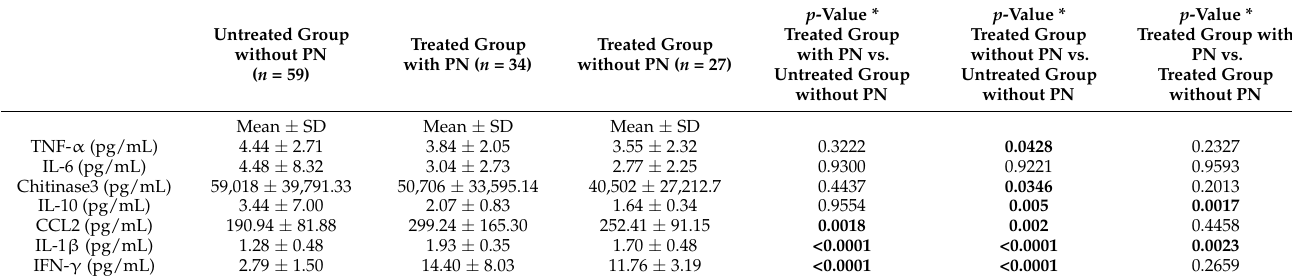
Table 3. Plasma concentrations of selected proinflammatory factors in patients with MM.